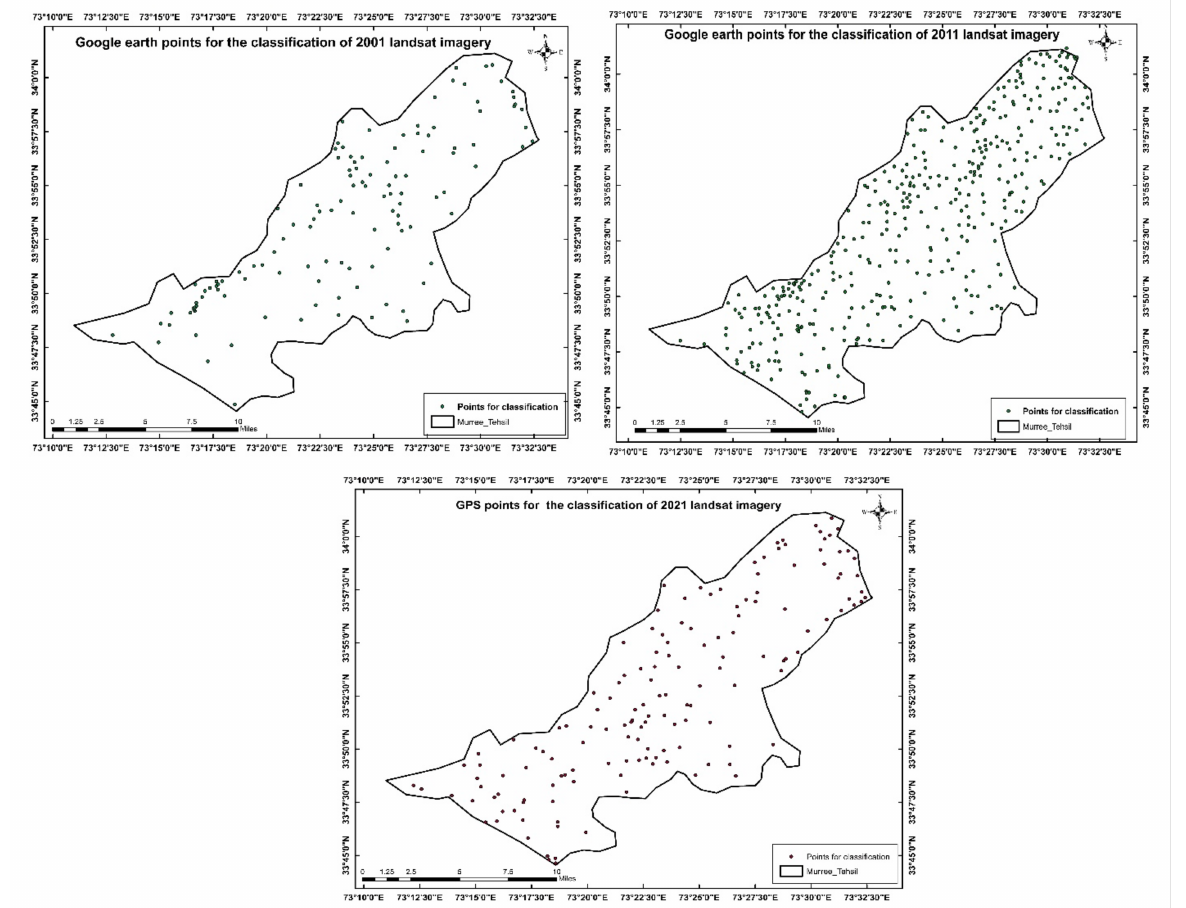
Figure 2. Map showing Google Earth and GPS points for classification of 2001, 2011 and 2021 Landsat